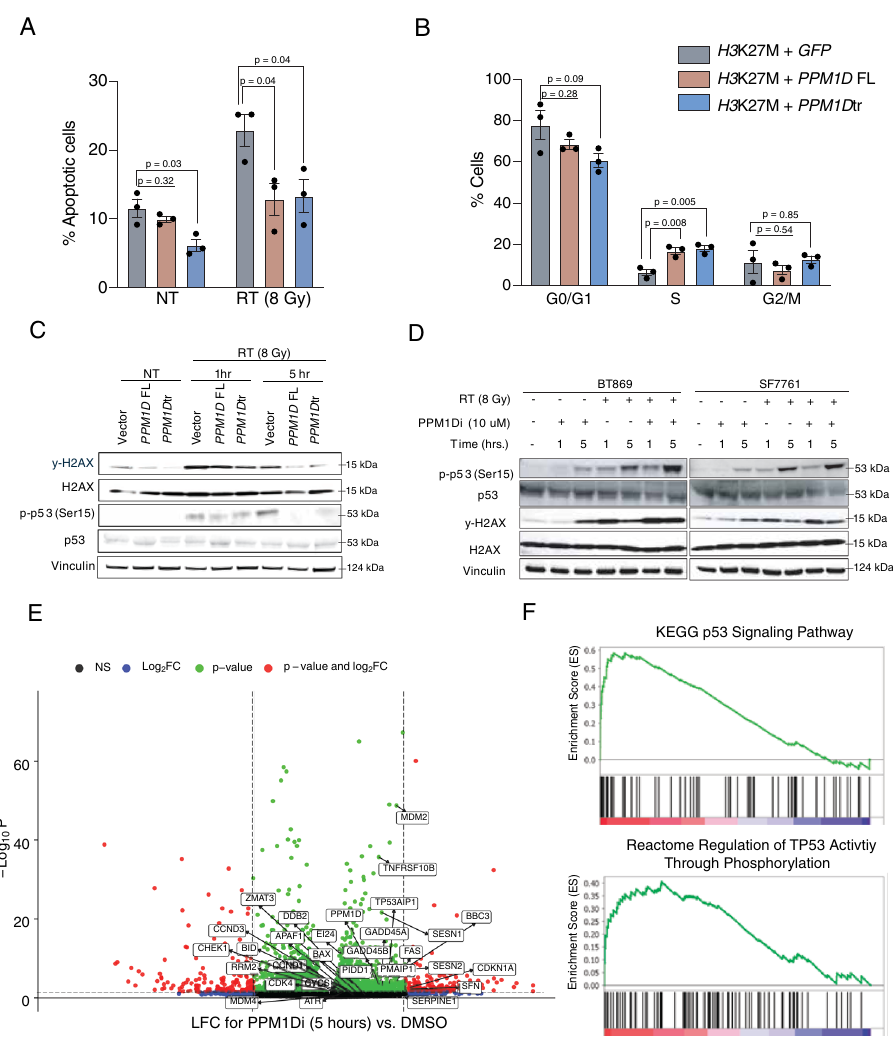
Fig. 4 PPM1D suppresses apoptosis, DDR, and p53 pathways. Apoptosis and cell cycle responses were assessed in isogenic mouse neural stem cells (mNSCs) overexpressing H3F3A K27M ( H3 K27M) mutation plus either eGFP (vector control), full-length PPM1D ( PPM1D FL), or C-terminus